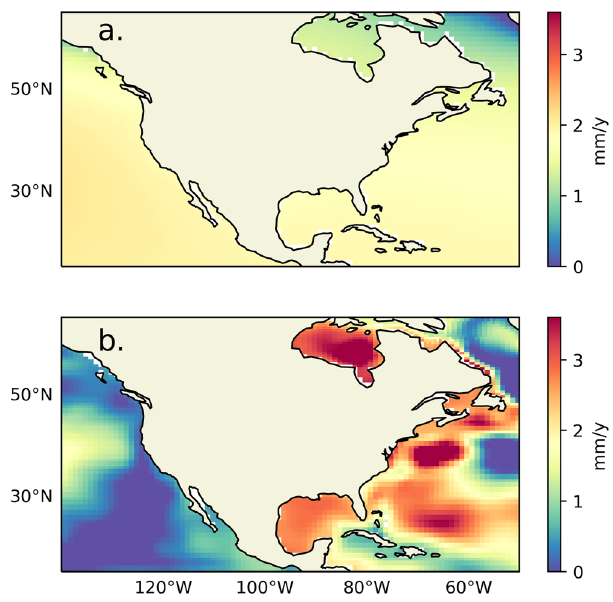
Fig. 2 Contributions to sea level trends. Estimated sea-level trends (1993 – 2018) due to ( a ) contemporary mass redistribution and ( b ) sterodynamic effects.